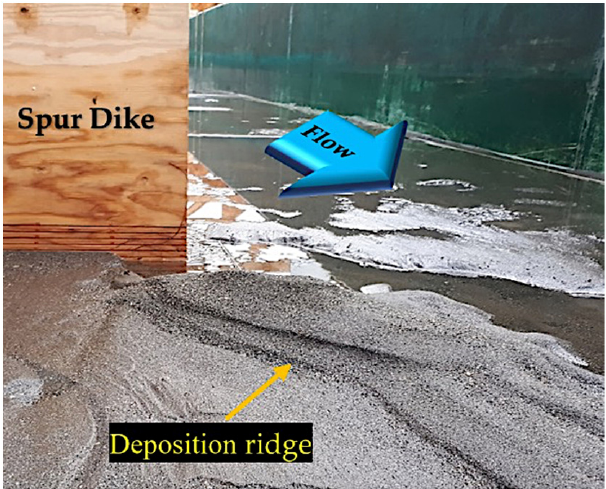
Figure 6. Deposition ridge in the downstream side of the spur dike.